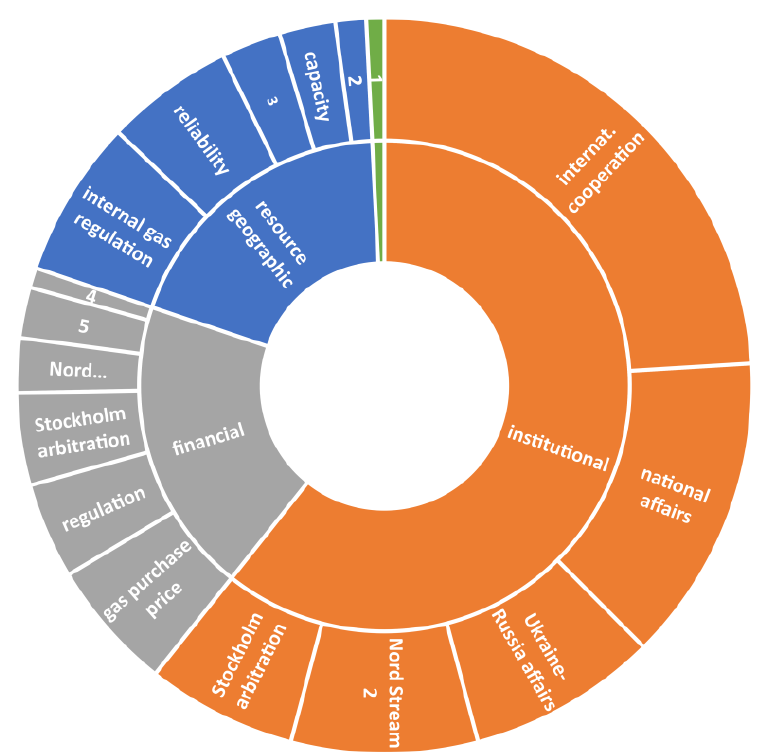
Figure 2. Political discourse on gas transit in Ukraine, 2014–2018. Source: Authors’ calculations. Notes: ecological (1); safety (2); supply diversification (3); transit fees (4); foreign investments (5).